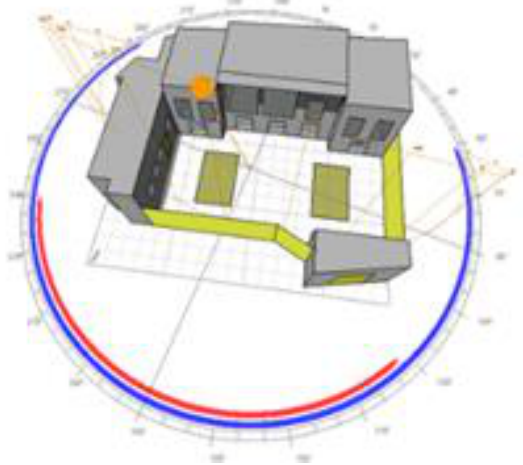
Figure 19 3D view of west wing of house No. 4, (July, 12:00